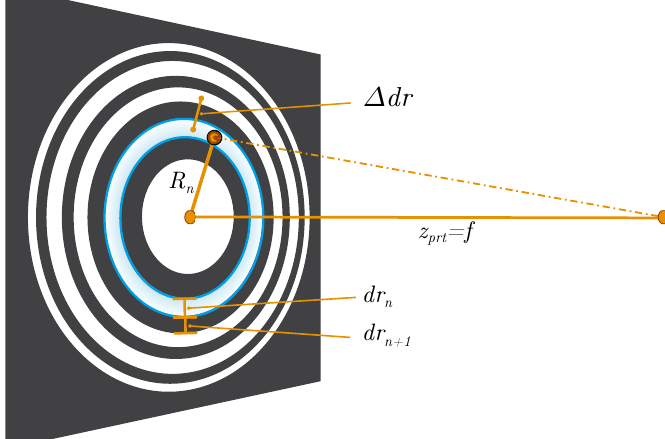
Figure 3. Fresnel Zone Plate (FZP) to estimate the radius R n of fringes and the size of fringe patterns; ∆ dr is the distance between two successive zone centers of the same parity (even or odd) and may be interpreted as the smallest detail to preserve when lowpass filtering fringe patterns; dr n is the width of n th